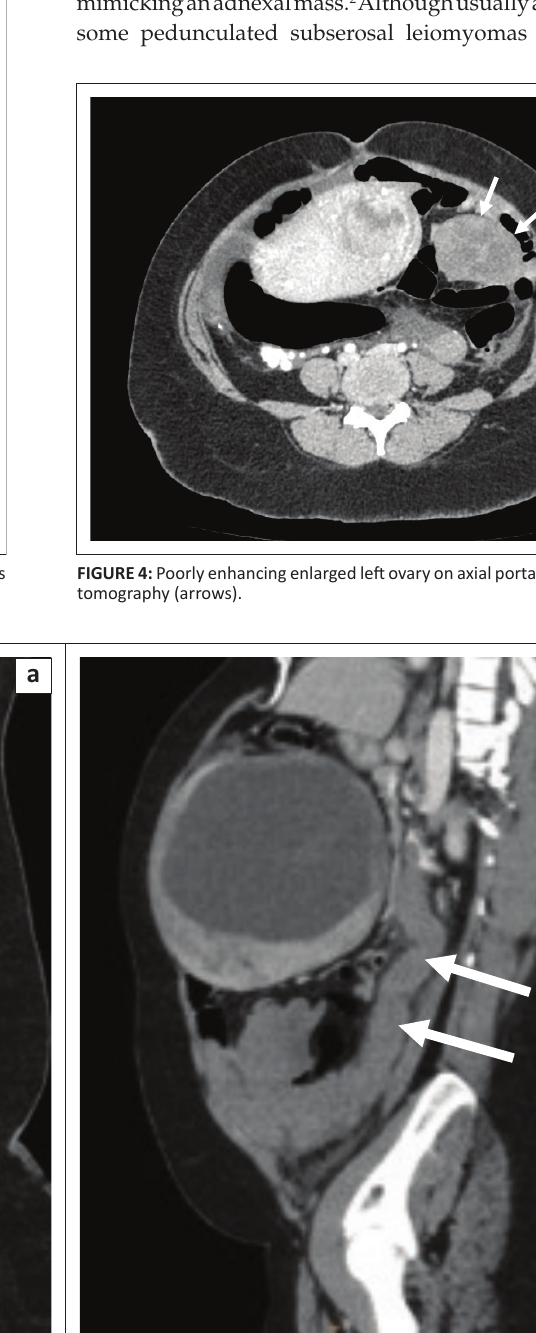
FIGURE 3: Coronal (a) and sagittal (b) portal venous computed tomography demonstrates tubular non-enhancing serpiginous structures corresponding to thrombosed left ovarian and parametrial veins (arrows).